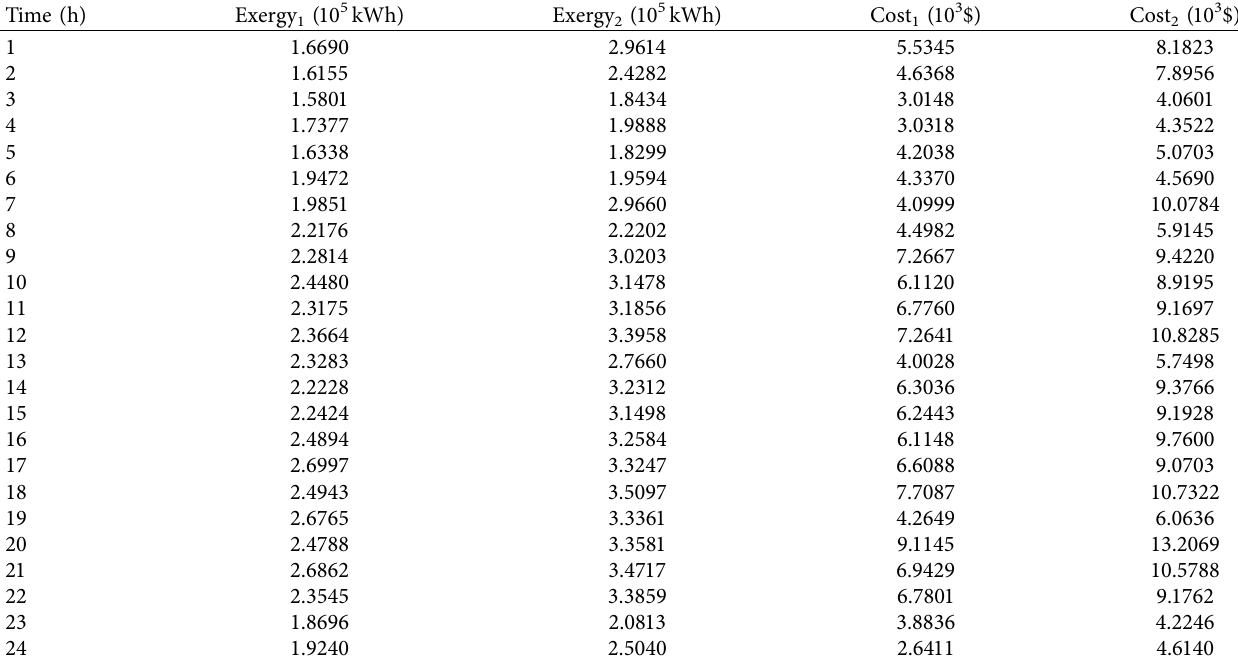
Table 6: Comparison of exergy input and cost under diferent situations in summer.